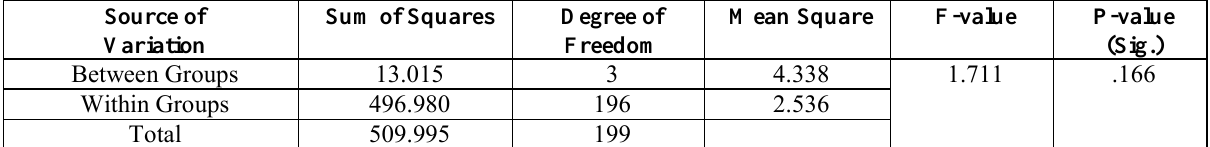
Analysis of Variance (ANOVA) results among North, East, West and South regions female baseball players with regard to the parameter Emotional Intelligence